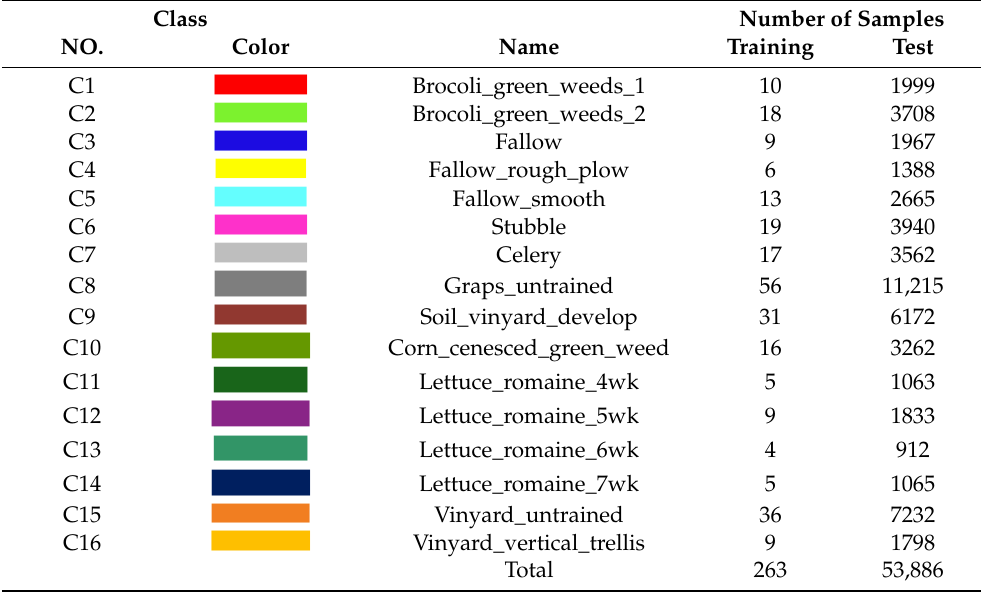
Table 4. Number of training samples and test samples in SV data